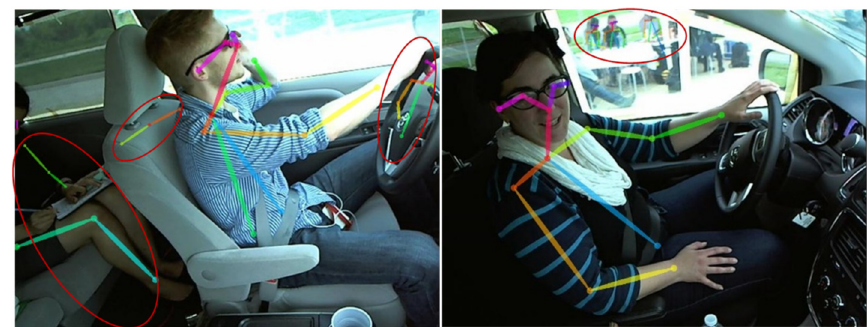
Figure 4. Misidentification